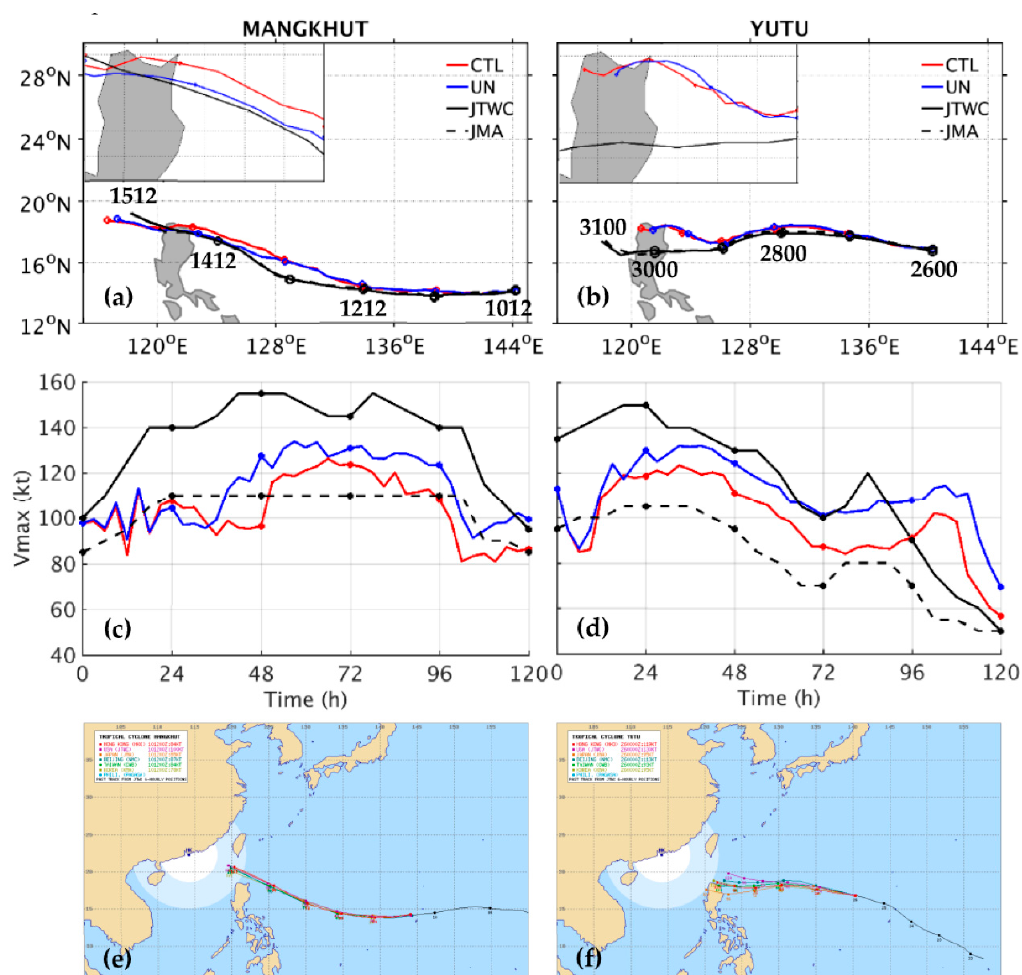
Figure 4. ( a ) Simulated tracks of Mangkhut for the coupled (CTL) (red line) and uncoupled (UN) (blue line) experiments and the best tracks of the JTWC (solid black line) and the JMA (dashed black line). ( b ) is as in ( a ) but for Yutu. Circles in ( a ) and ( b ) mark the typhoon centers every 24 h, associated with the numbers indicating the UTC time. ( c ) and ( d ) are the same as in ( a ) and ( b ) but for the time evolution of 10 m maximum wind speed (kt), respectively. Track forecasts at several operational centers (from https://www.typhoon2000.ph/multi/ acessed on 14 August 2021) for ( e ) Mangkhut and ( f ) Yutu. The simulated time is for Mangkhut from 1200 UTC 10 September to 1200 UTC 15 September 2018, while it is for Yutu from 0000 UTC 26 October to 0000 UTC 31 October.